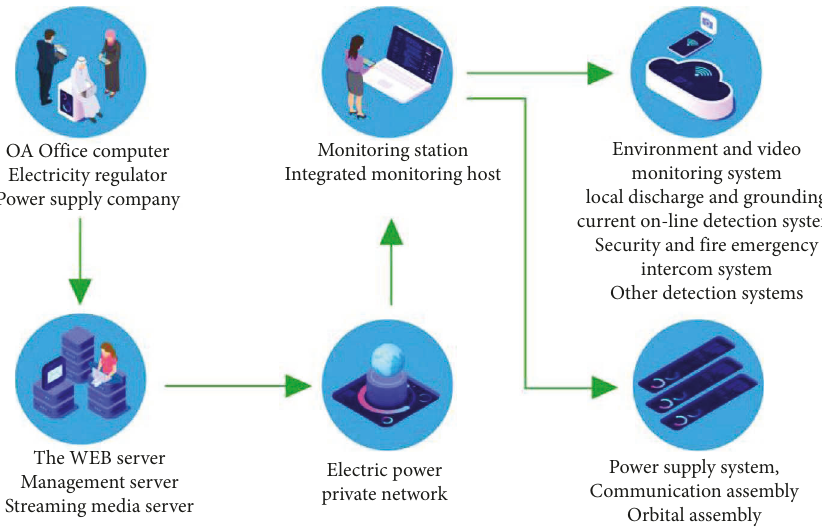
Figure 1: Robot control system in power